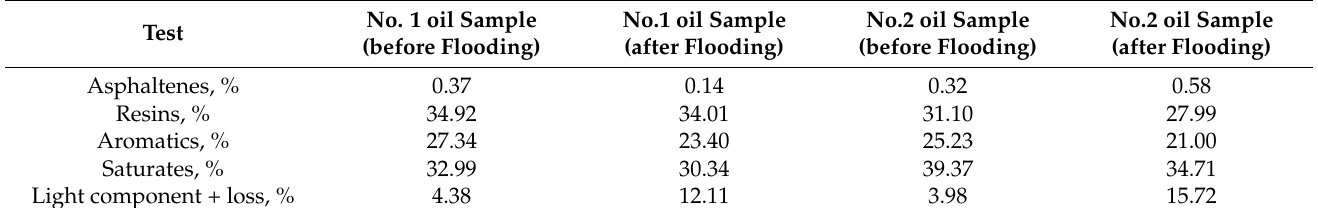
Table 3. SARA composition of two different compound oil before and after steam flooding.